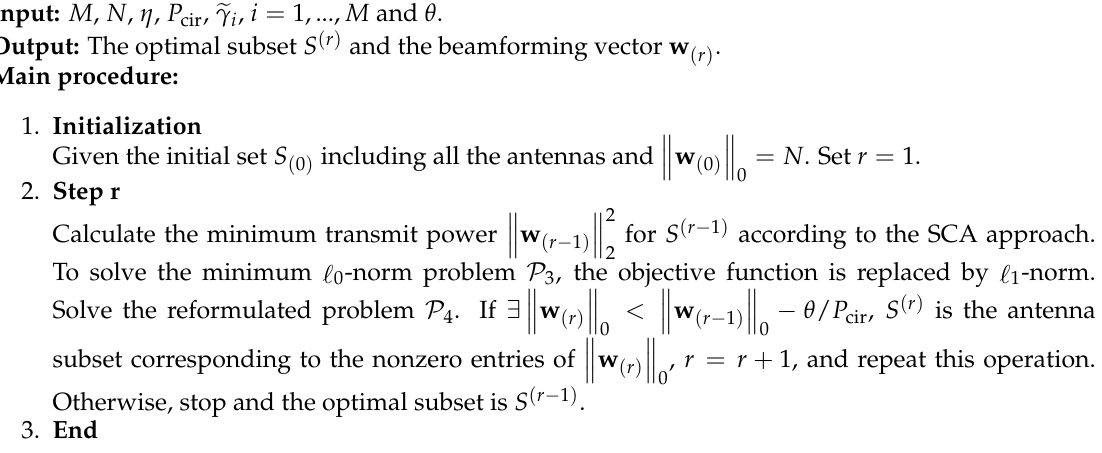
Algorithm 1 (cid:96) 0 -Norm Minimization (L0NM)